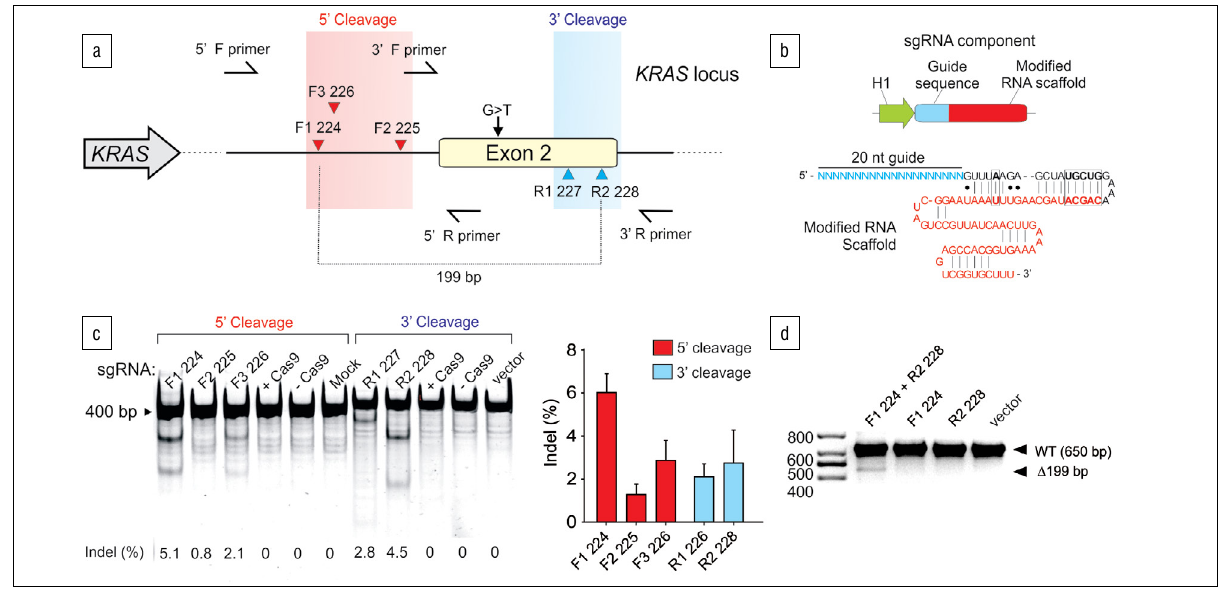
Figure 1: CRISPR/Cas9-mediated targeting of the human KRAS gene. (a) A schematic of the KRAS gene locus chosen for CRISPR/Cas9 targeting. The sgRNA target sites were designed around an oncogenic c.35G>T mutation in the KRAS gene, with the cleavage sites depicted as arrowheads. Two primer sets were used to amplify cleavage regions that were 5 ʹ and 3 ʹ of the point mutation. (b) The sgRNA construct was driven by an H1 Pol-III promoter for the expression of the guide sequence and the RNA scaffold as a single chimeric molecule. The sgRNA architecture used was previously optimised to improve sgRNA expression and Cas9 loading. 22 (c) A T7E1 assay showed the performance of each sgRNA at generating indels ( n =3; mean±SD, * p <0.05, ** p <0.01, unpaired Student’s t -test). (d) The simultaneous application of sgRNA F1 224 and sgRNA R2 228 led to the deletion of 199 bp in the KRAS gene, which was detected with